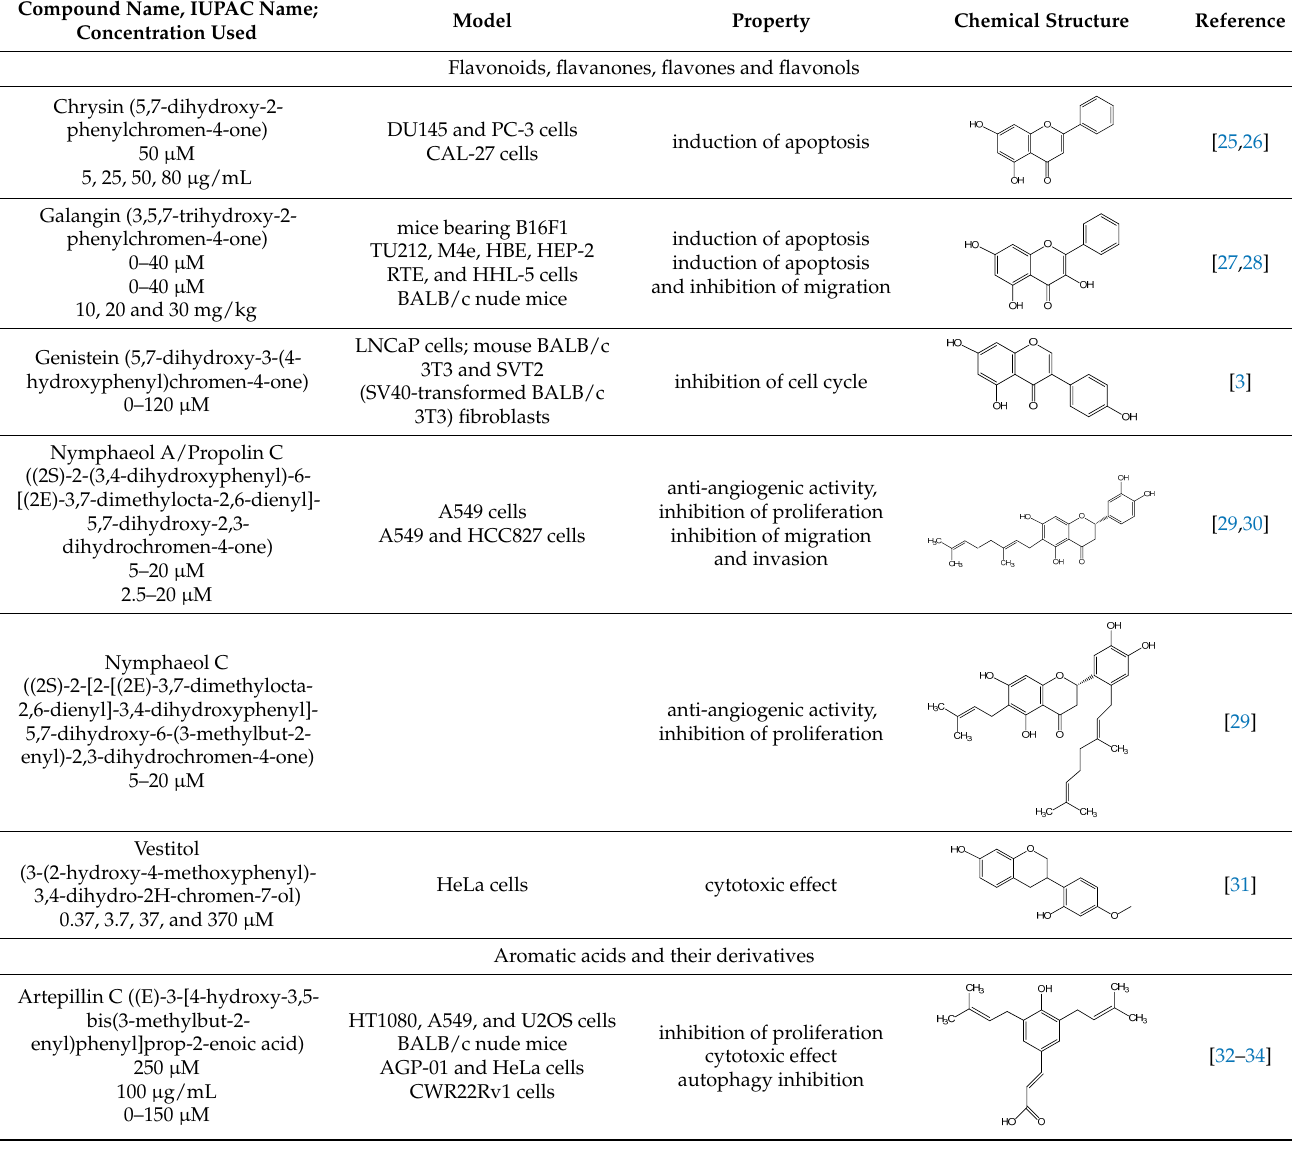
Table 1. Propolis compounds with anticancer activity (in vitro and in vivo models).